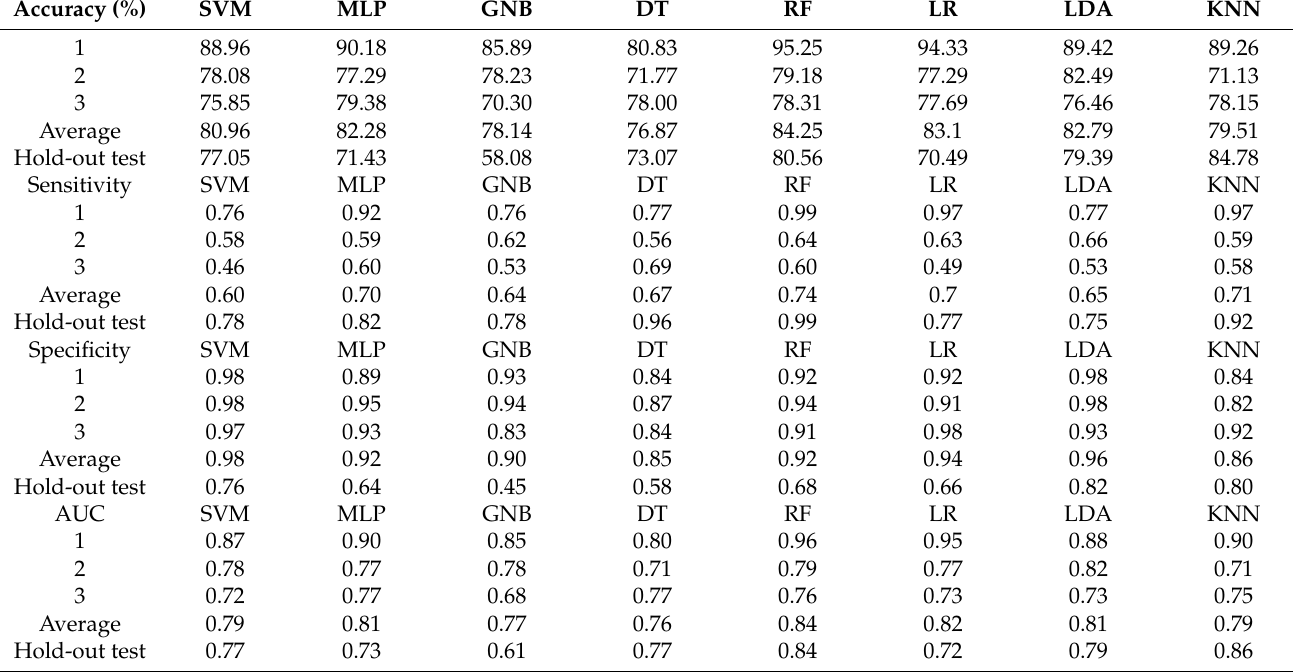
Table 4. Hold-out analysis results for comparisons of BPW indices between Data A and Data